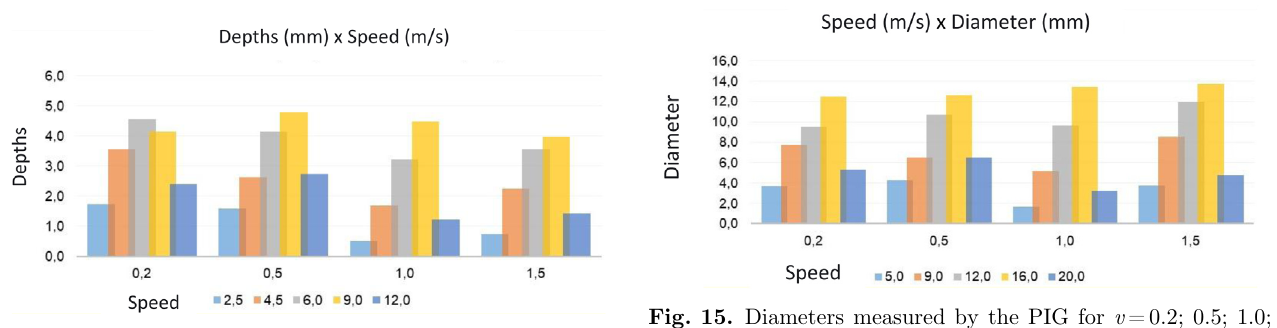
Fig. 14. Depths measured by PIG for v = 0.2; 0.5; 1.0; 1.5 m/s.